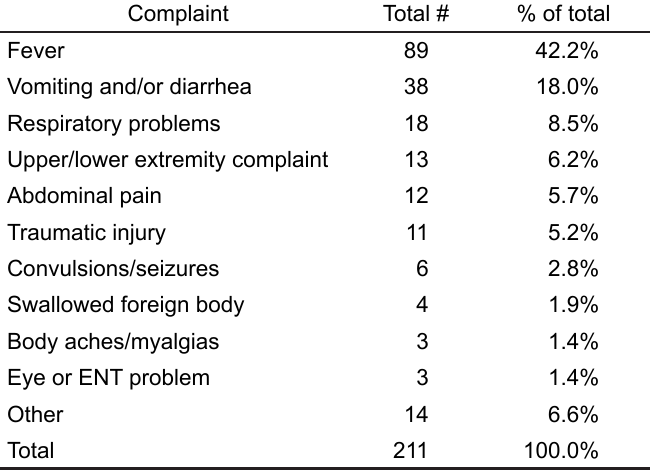
Table 1. Chief complaint by age, 0-5yrs.